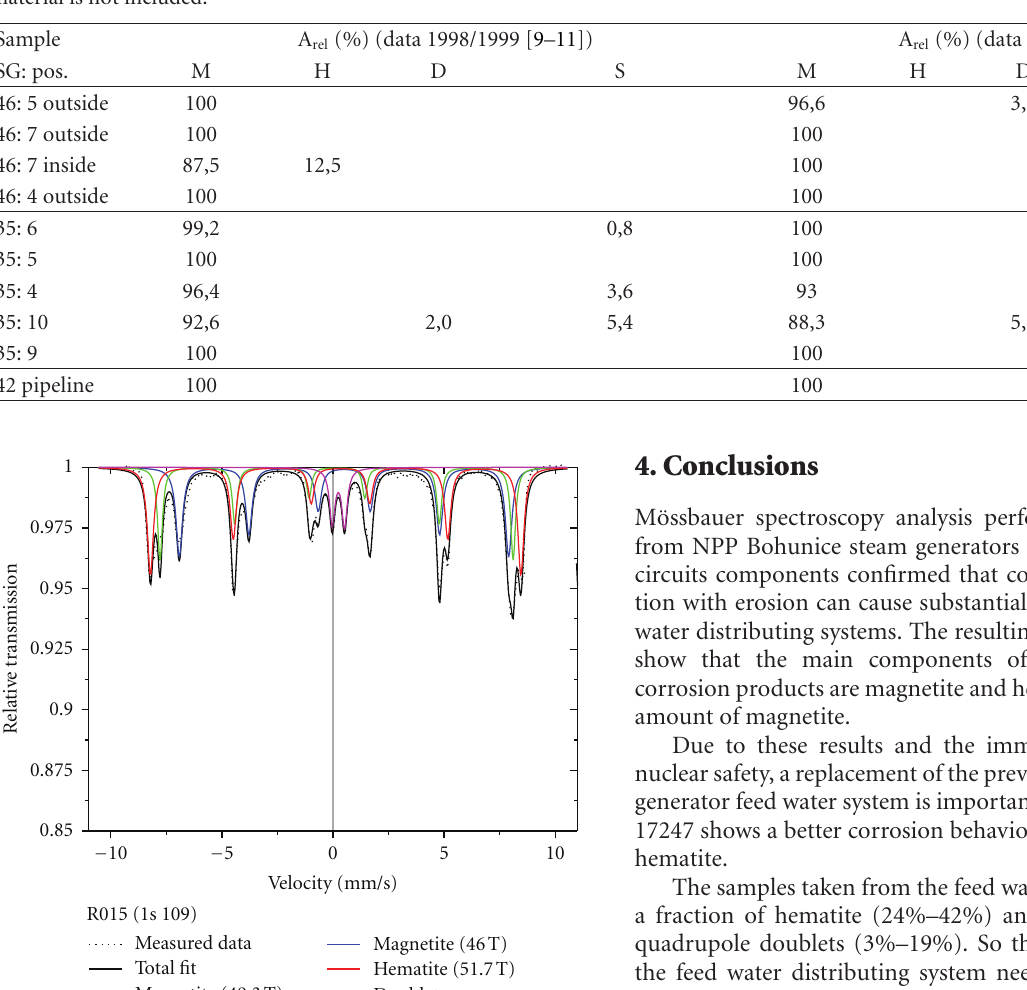
Table 3: Comparison of the results from this work with literature data. Magnetite (M), hematite (H), doublet (D), singlet (S). The base material is not included.